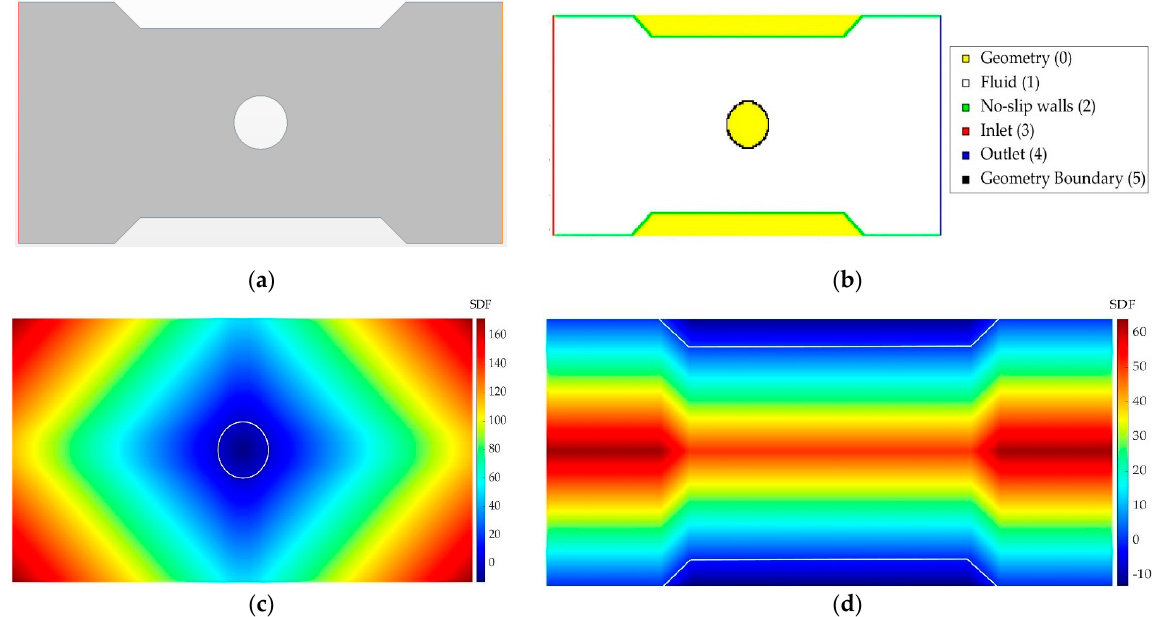
Figure 13. Information about the used domain with a different channel. ( a ) Numerical domain; ( b ) FRC layer; ( c ) SDF layer of the geometry (the contour of the geometry is drawn in white); ( d ) SDF layer of the walls (the contour of the walls is drawn in white).